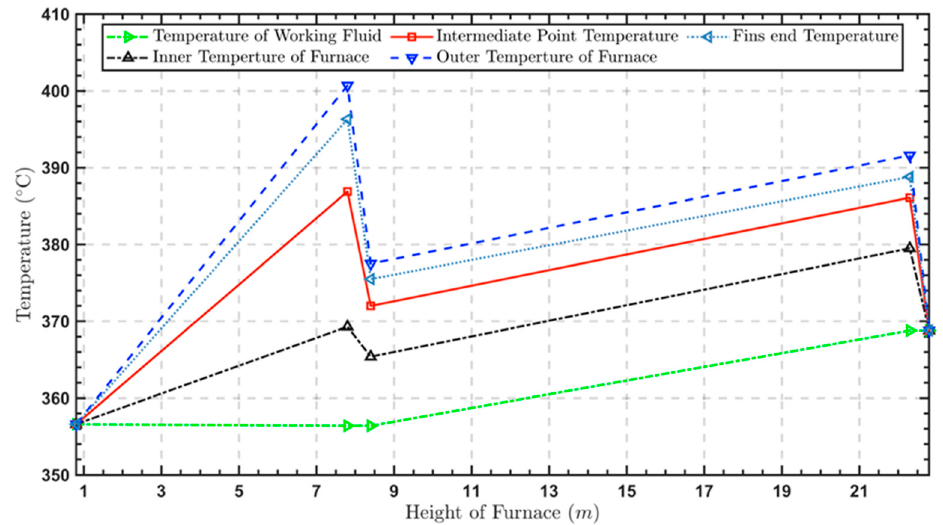
Figure 18. Wall temperature distribution of no. 172 circuit in upper